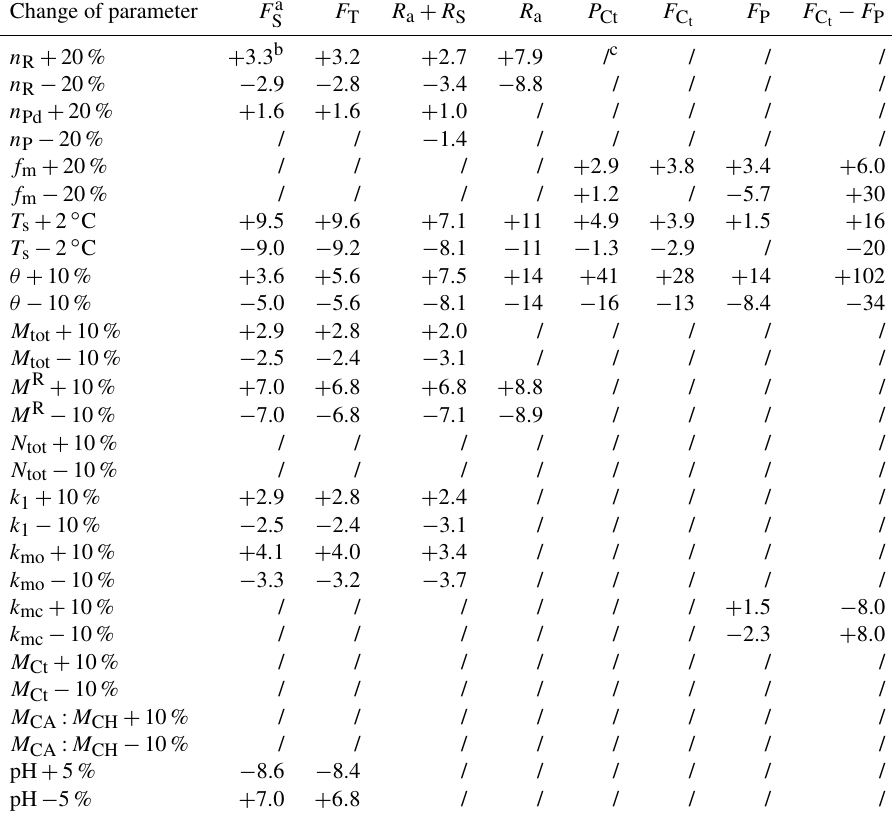
Table 4. Sensitivity of simulated F S and its componential fluxes to manipulations of parameter values. Change of